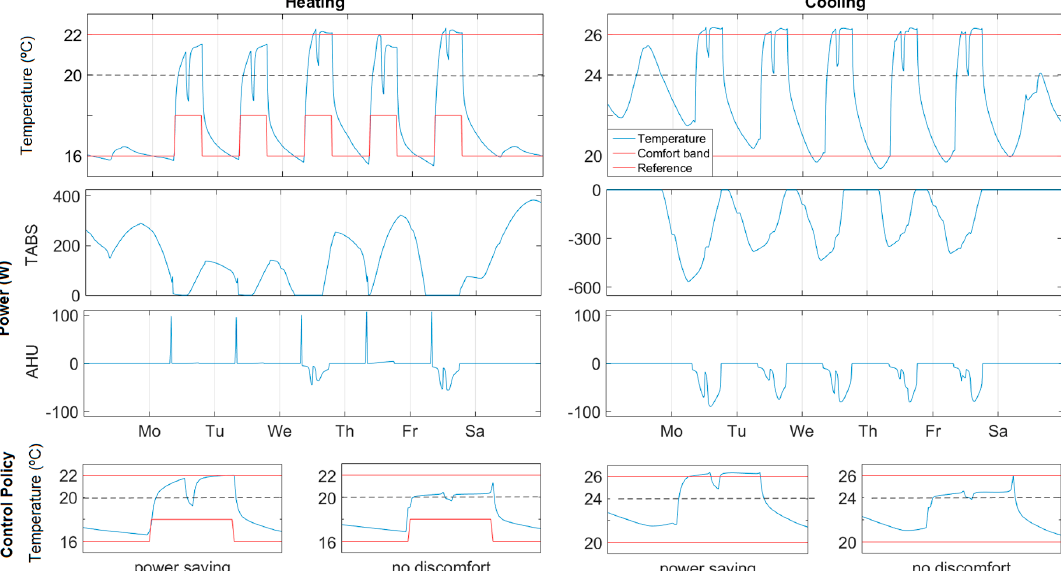
Figure 7. One-week response of the control for heating and cooling configurations. Temperature evolution, and TABS and AHU system power use are shown. One-day temperature evolution for the selected configuration, power saving, against a no discomfort policy is also presented at the bottom.